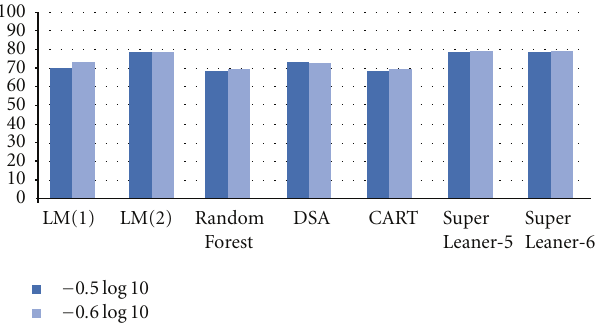
Figure 2: Rates of patients being well classified for threshold − 0.5 for all models applied on the Jaguar trial and − 0 . 6log 10